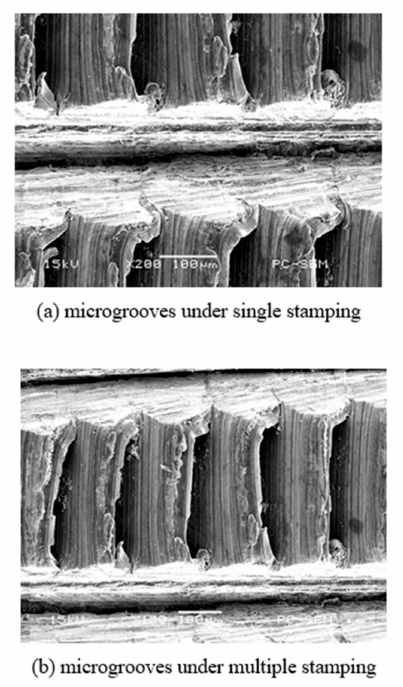
Figure 12. SEM section images of microgrooves under the stamping process, ( a ) single stamping; ( b ) multiple